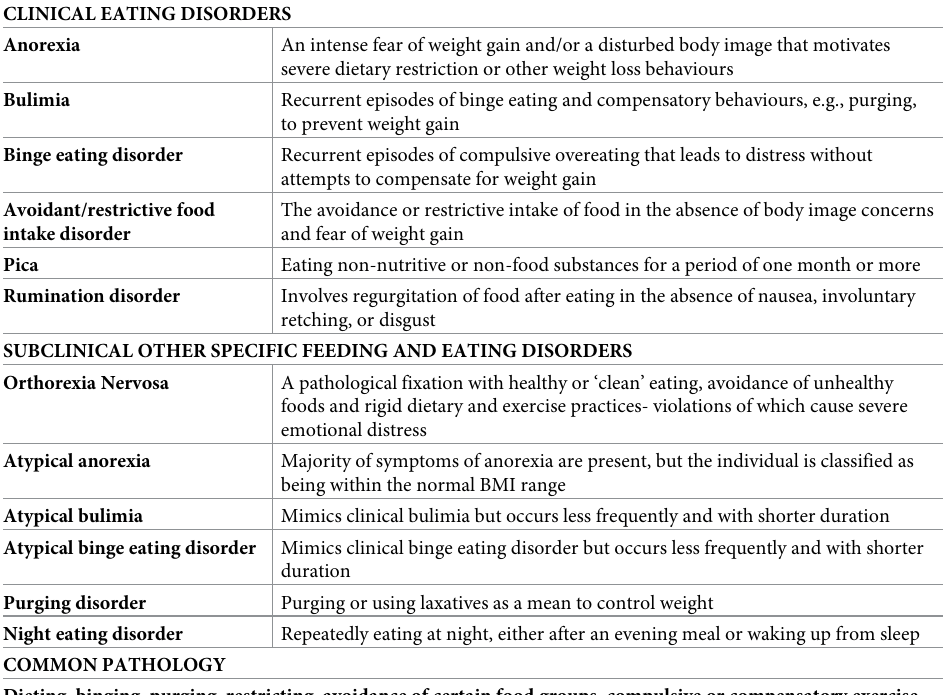
Table 1. Types of clinical and subclinical eating disorders and typical